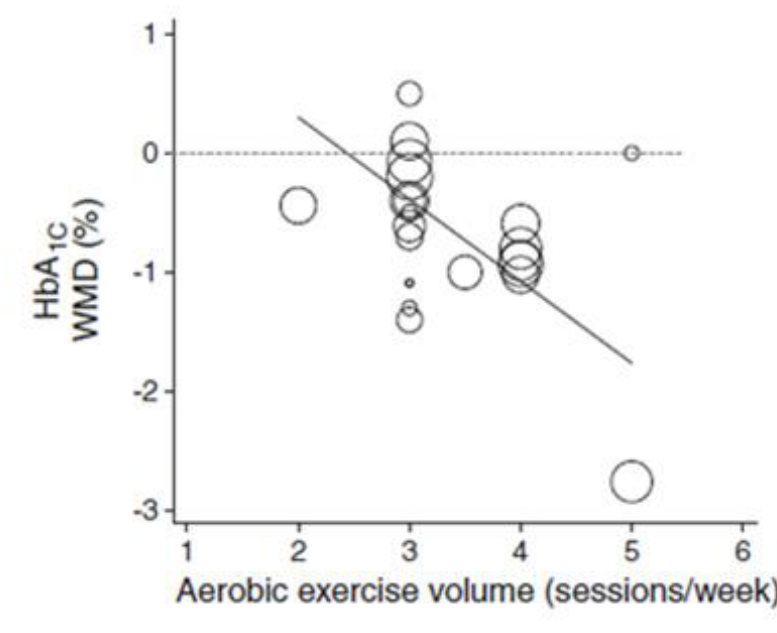
Legend: HbA1c=hemoglobin A1c, WMD=weighted mean